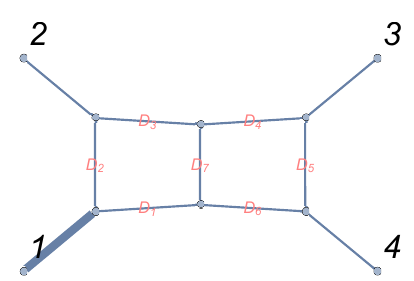
Figure 6 . Double box diagram with one external massive leg. This graph is produced by the package Azurite .